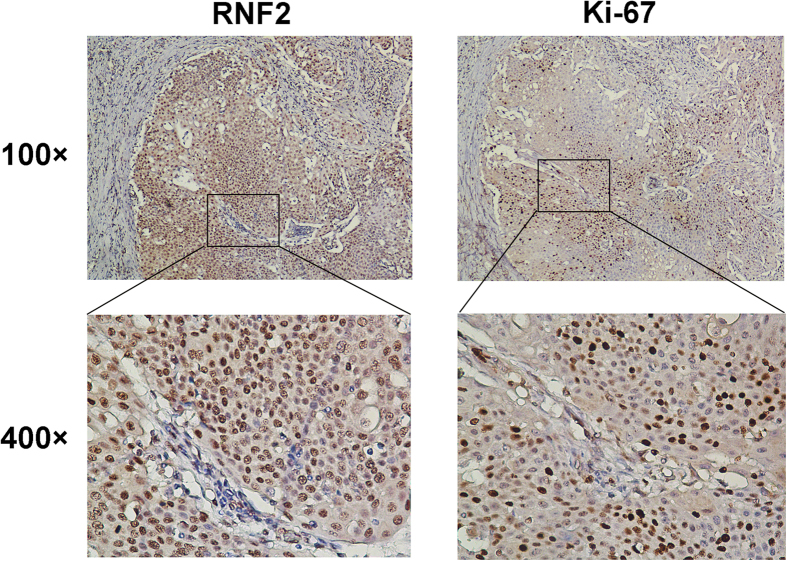
RNF2 levels are positively correlated with Ki-67 expression in primary UCB specimens.Representative image shows that overexpression of RNF2 and high-level expression of Ki-67 was examined by IHC in a UCB case (case 36).